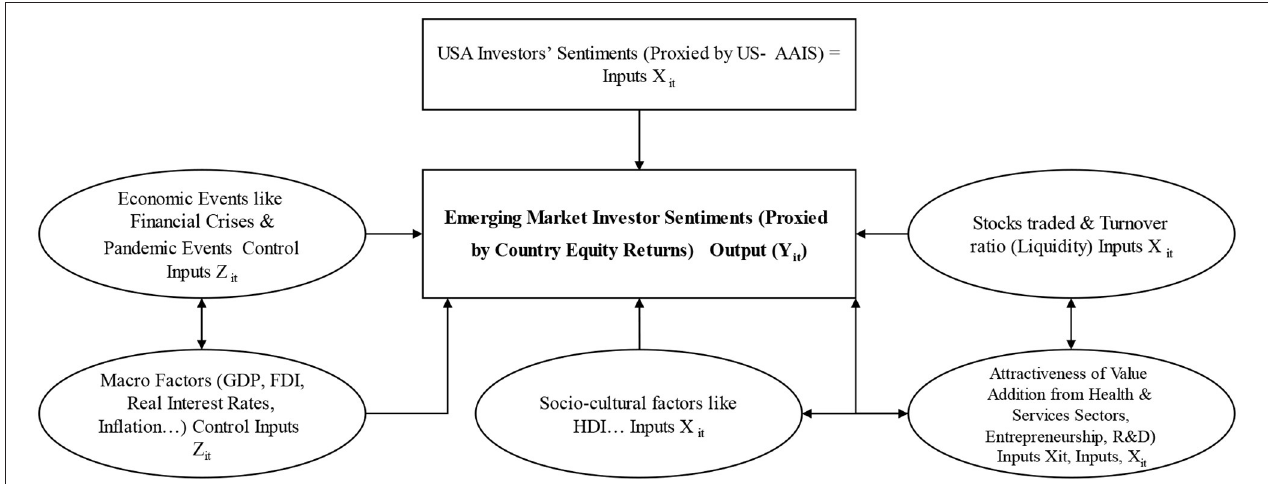
FIGURE 2 | Proposed conceptual